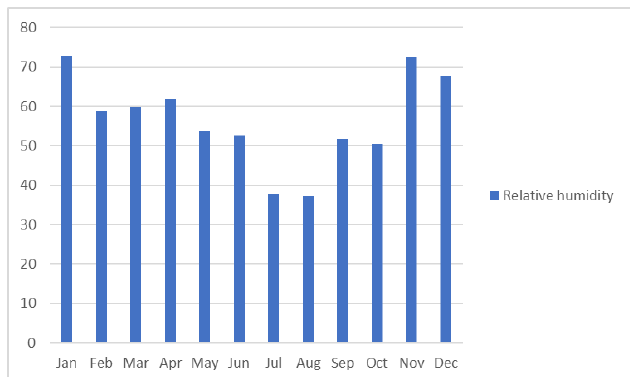
Figure 3 . Relative humidity in the study